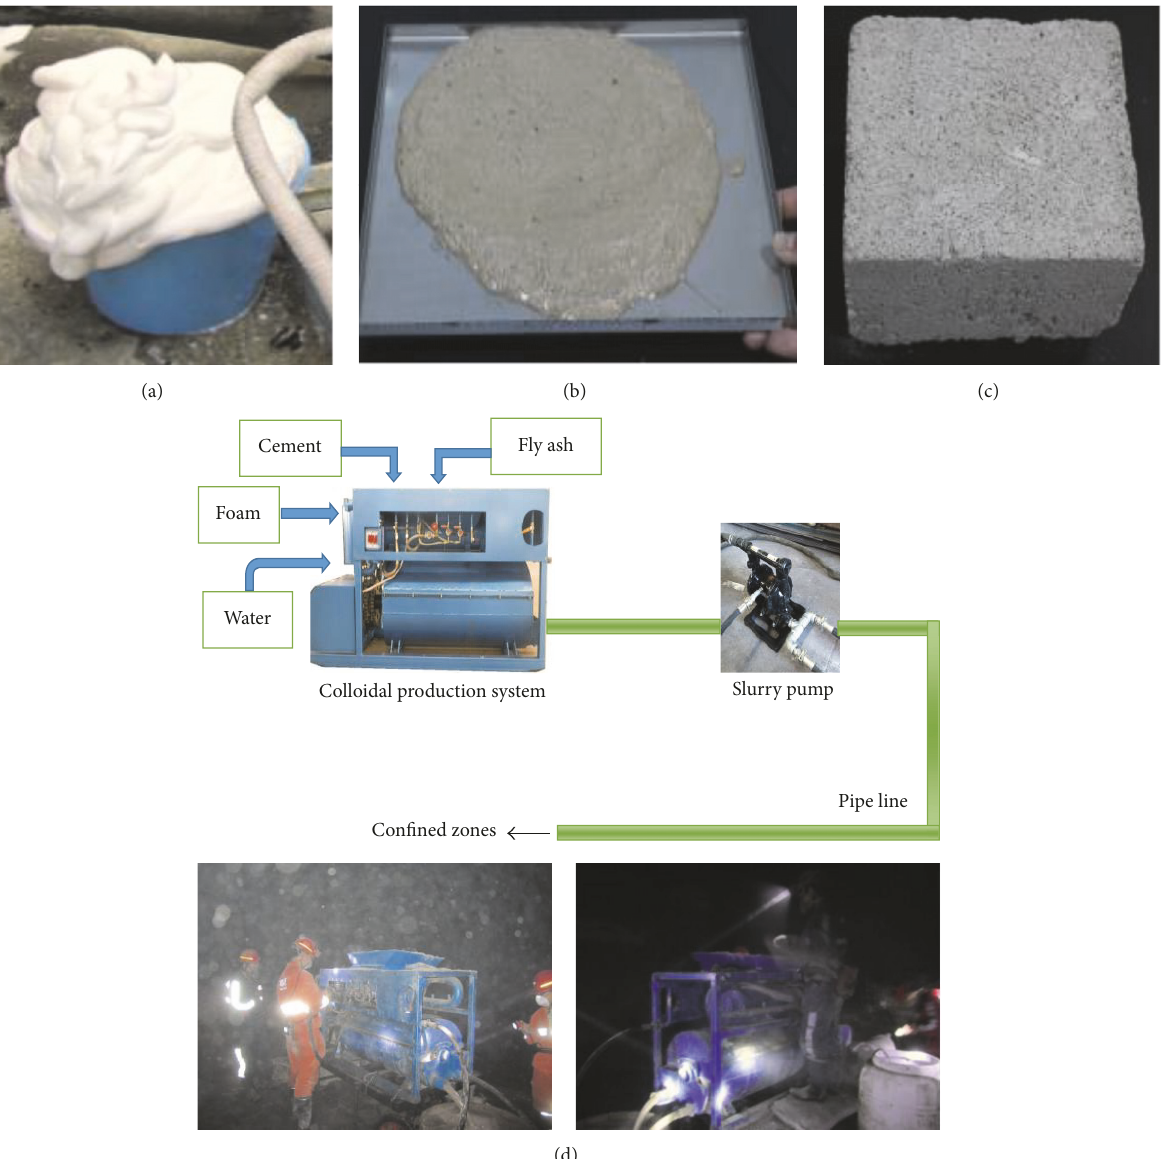
Figure 11: ZMJ-F grouting system: (a) foam, (b) foam slurry, (c) solidified filling material, and (d) inorganic foam filling equipment, including foam slurry production machine, transfer pump, and control system.